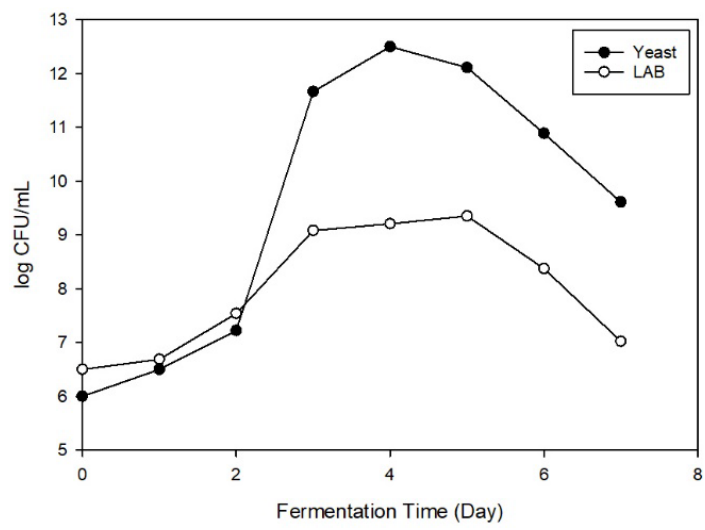
Figure 1. The growth curve of yeast and lactic acid bacteria.